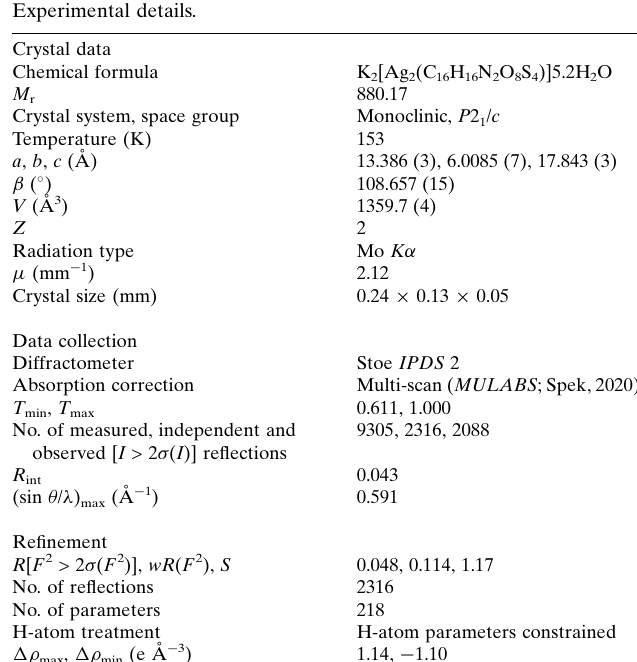
, z (cid:4) 1 ; (vi) x , (cid:4) y + 3 , 2 2 2